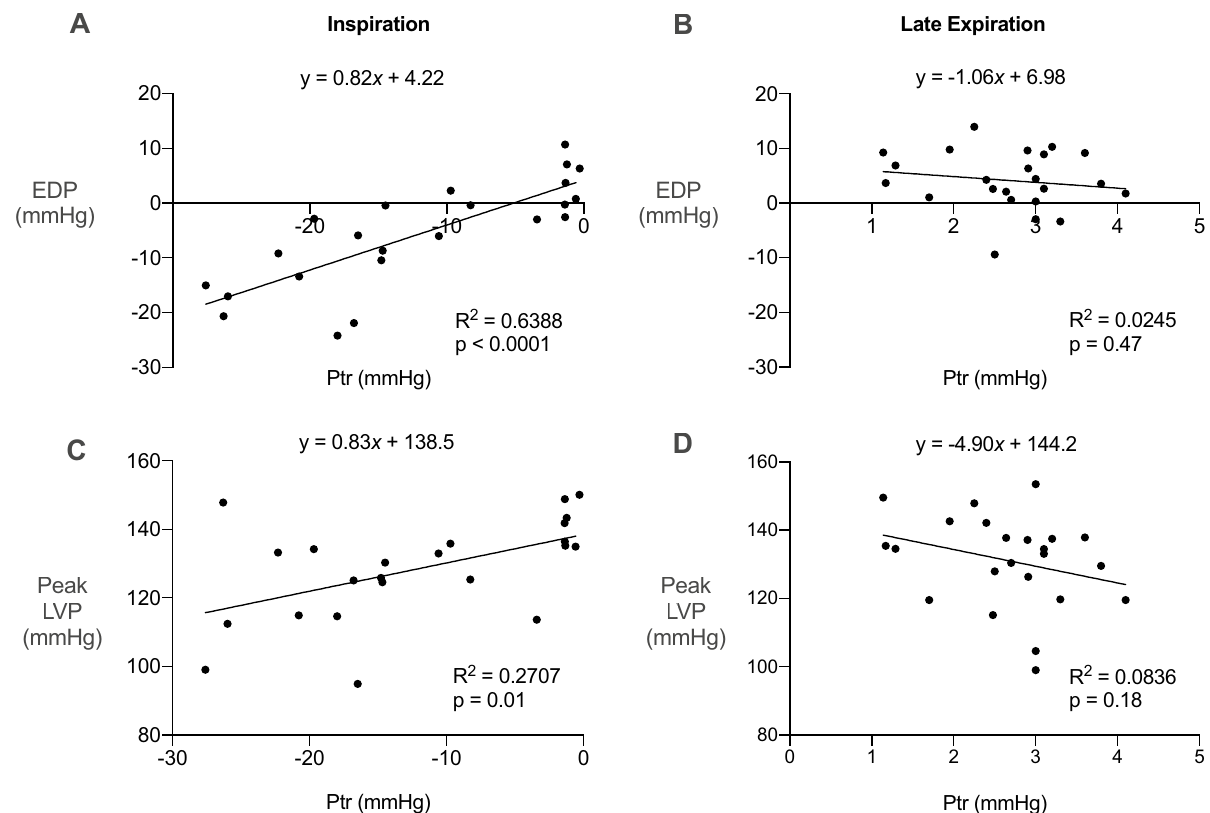
Figure 4. Diastolic and systolic pressures are predicted by inspiratory tracheal pressure. Linear regression of tracheal pressure versus end diastolic pressure (EDP) and peak left ventricle pressure (peak LVP). ( A ) EDP during inspiration. ( B ) EDP during late expiration. ( C ) Peak LVP during inspiration. ( D ) Peak LVP during late expiration. All data were analyzed by linear regression, n =